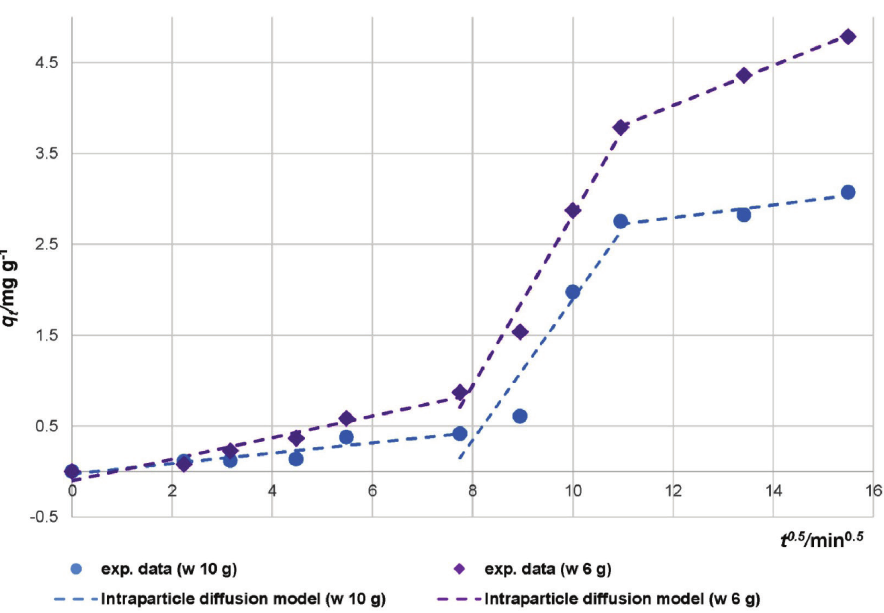
Fig. 4 – Experimental kinetics data and intraparticle diffusion model